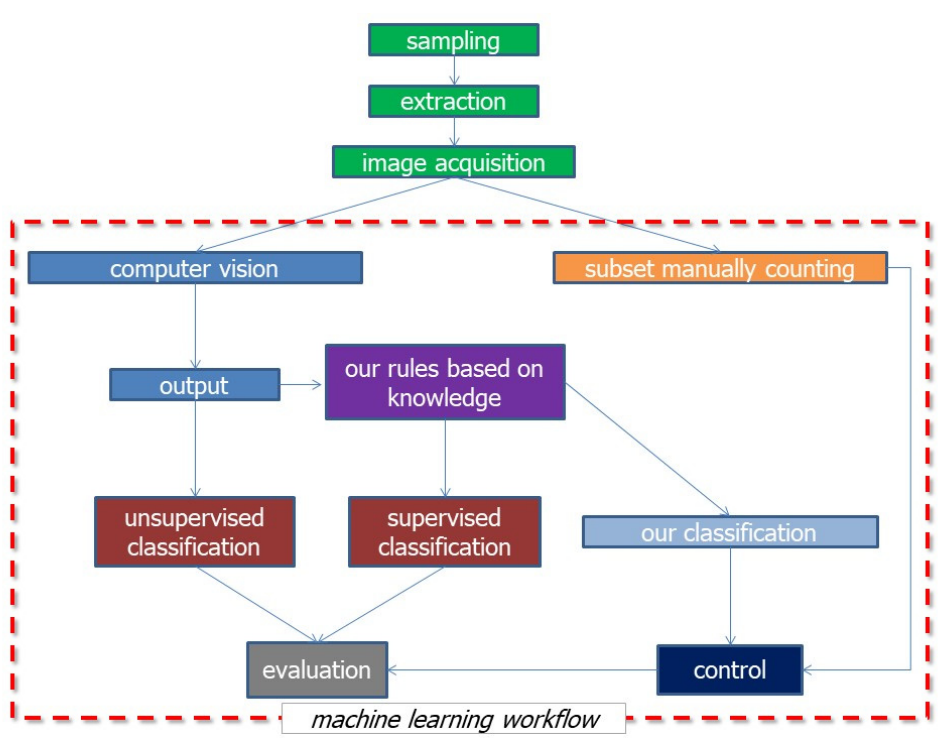
Figure 1. All the workflow adopted.